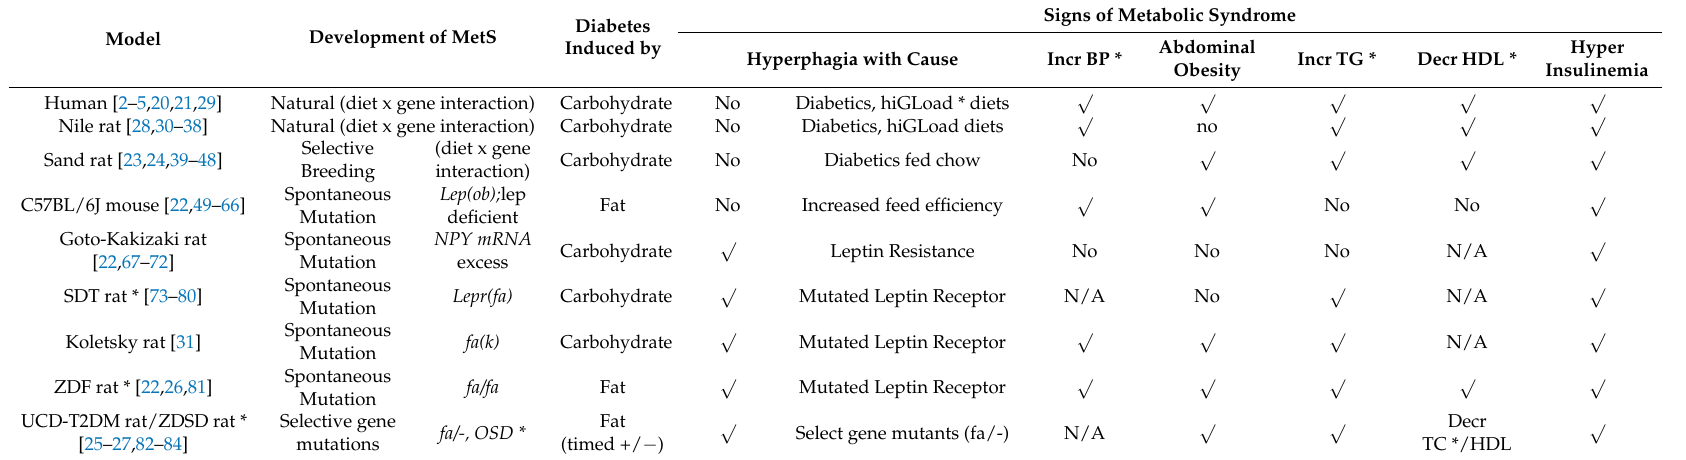
Table 1. Risk indicators of Metabolic Syndrome (MetS) in humans and selected rodent